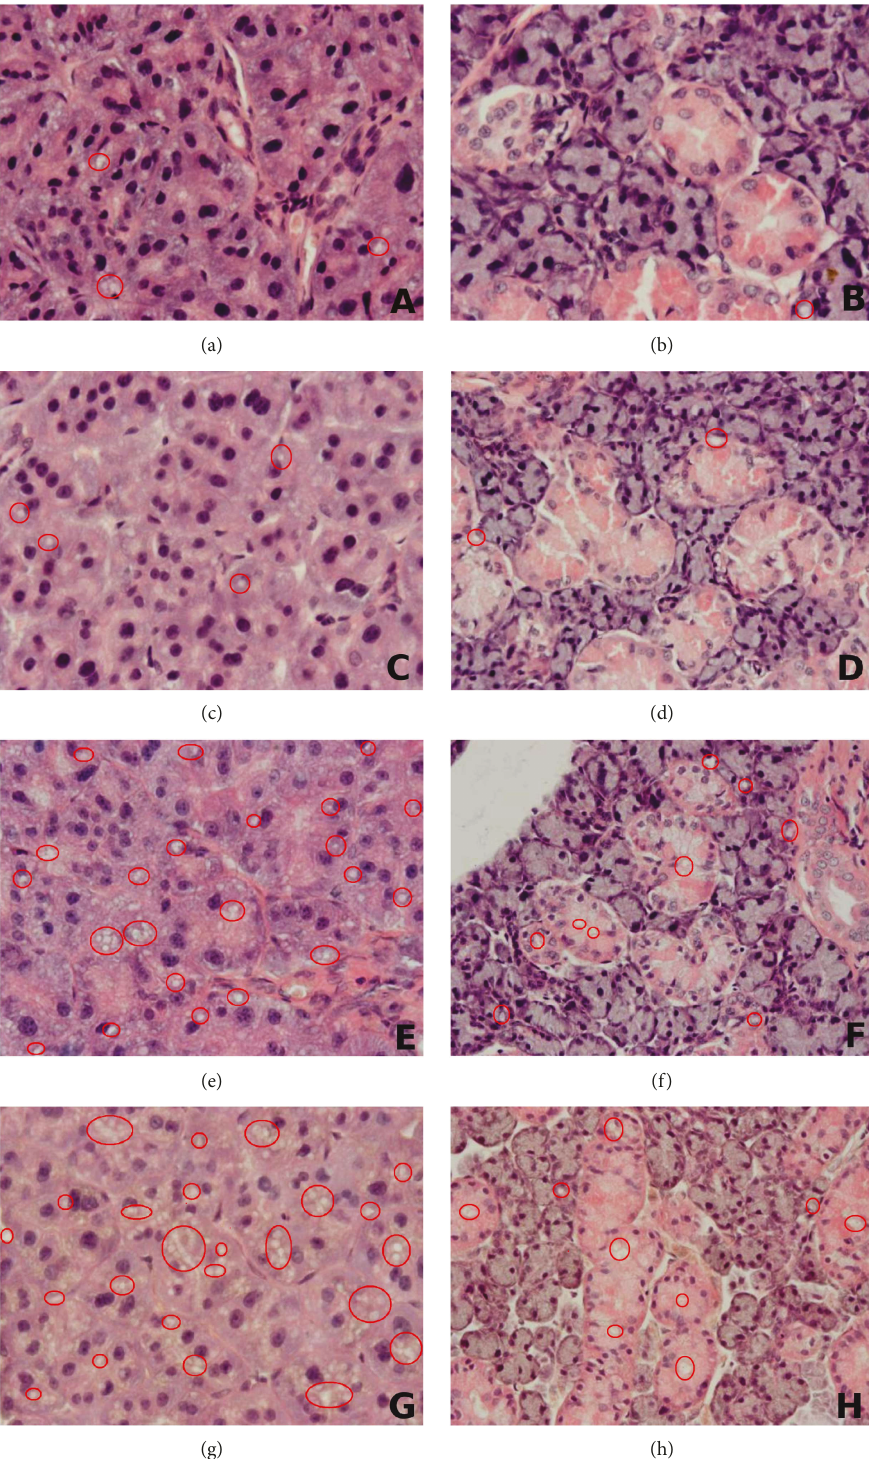
Figure 5: The e ff ect of STZ-induced diabetes on histological observation in the salivary glands. C2 and C4 are the control groups; STZ2 and STZ4 are the diabetic groups; (a) parotid gland of the C2 rats; (b) submandibular gland of the C2 rats; (c) parotid gland of the C4 rats; (d) submandibular gland of the C4 rats; (e) parotid gland of the STZ2 rats; (f) submandibular gland of the STZ2 rats; (g) parotid gland of the STZ4 rats; (h) submandibular gland of the STZ4 rats; red circles indicate